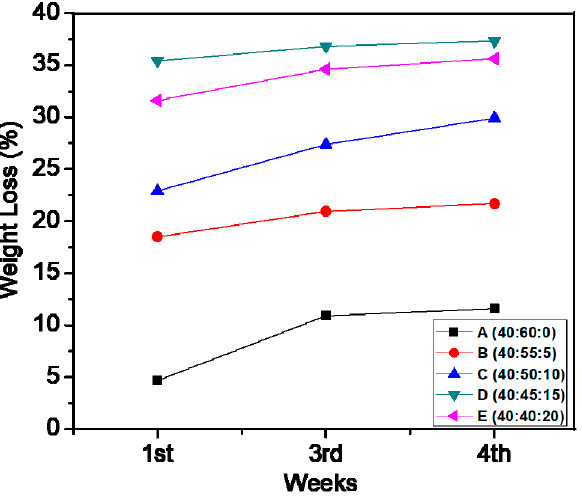
Figure 4. Percentage of weight loss of nanocomposite-based sca ff old n-HA / Ch / CMC taken in the 1st, 3rd, and 4th weeks.